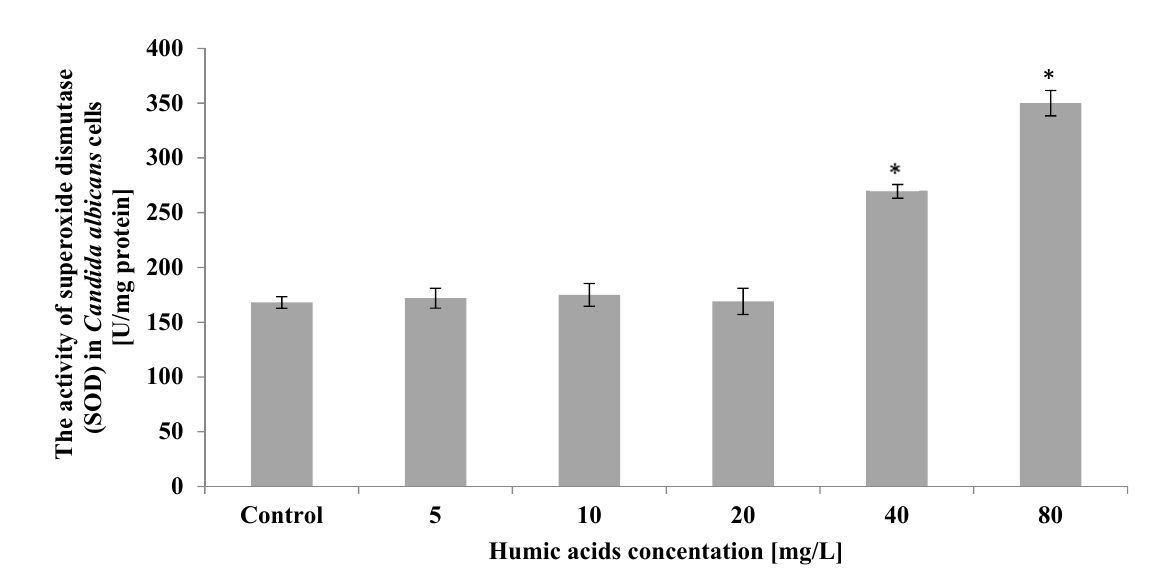
Figure 7. The effect of humic acids on activity of superoxide dismutase (SOD) in Candida albicans cells on the 5th day of culture ( n = 8, average values ± SD, p ≤ 0.01), (*) shows statistically significantly different values in comparison with control sample.